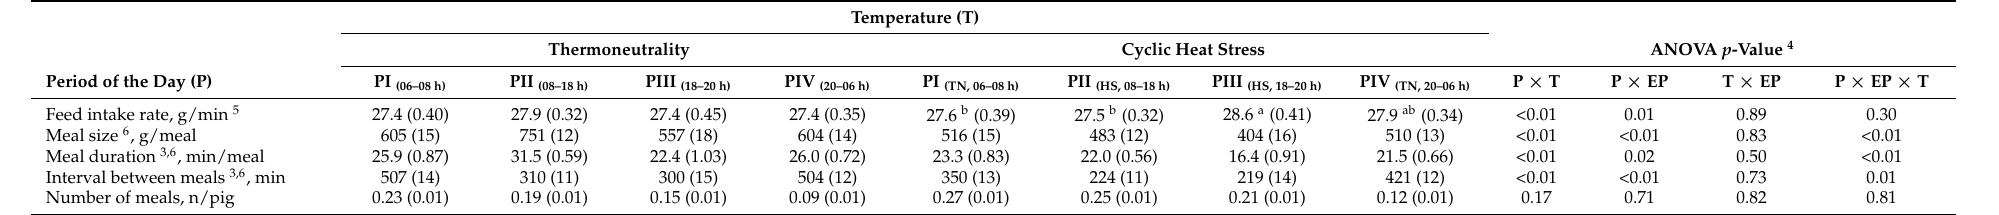
Table 1. Feeding behavior of finishing pigs exposed to thermoneutrality or cyclic heat stress conditions, according to the period of the day 1,2